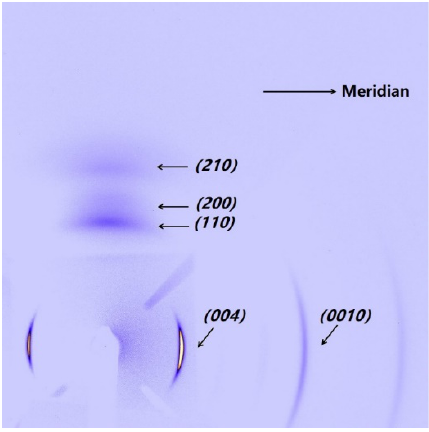
Figure 1. 2D WAXD patterns of PI fiber (fiber treated at 40 °C/min from room temperature to 400 °C as an example). The steaks of (004) and (0010) and the streaks of (110), (200) and (210) are on the meridian and equatorial directions of the PI fiber, respectively.